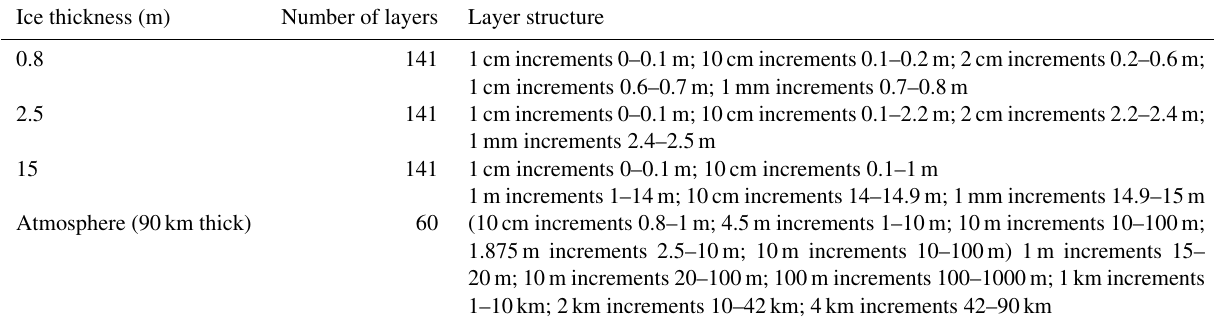
Table 2. TUV-snow model sea ice input parameters are derived from the literature and detailed in Marks and King (2014). Ice thickness (m) Number of layers Layer